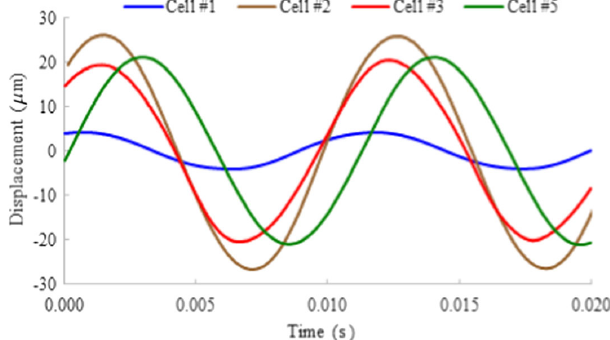
FIG. 9. Displacement oscillations at the 95 Hz mechanical mode. These are measured from the accelerometers attached on the equators and aligned to the cavity axis (longitudinal direc- tion). The phase advances are 28° from Cell #1 to Cell #2, − 4 ° from Cell #2 to Cell #3, 52° from Cell #3 to Cell